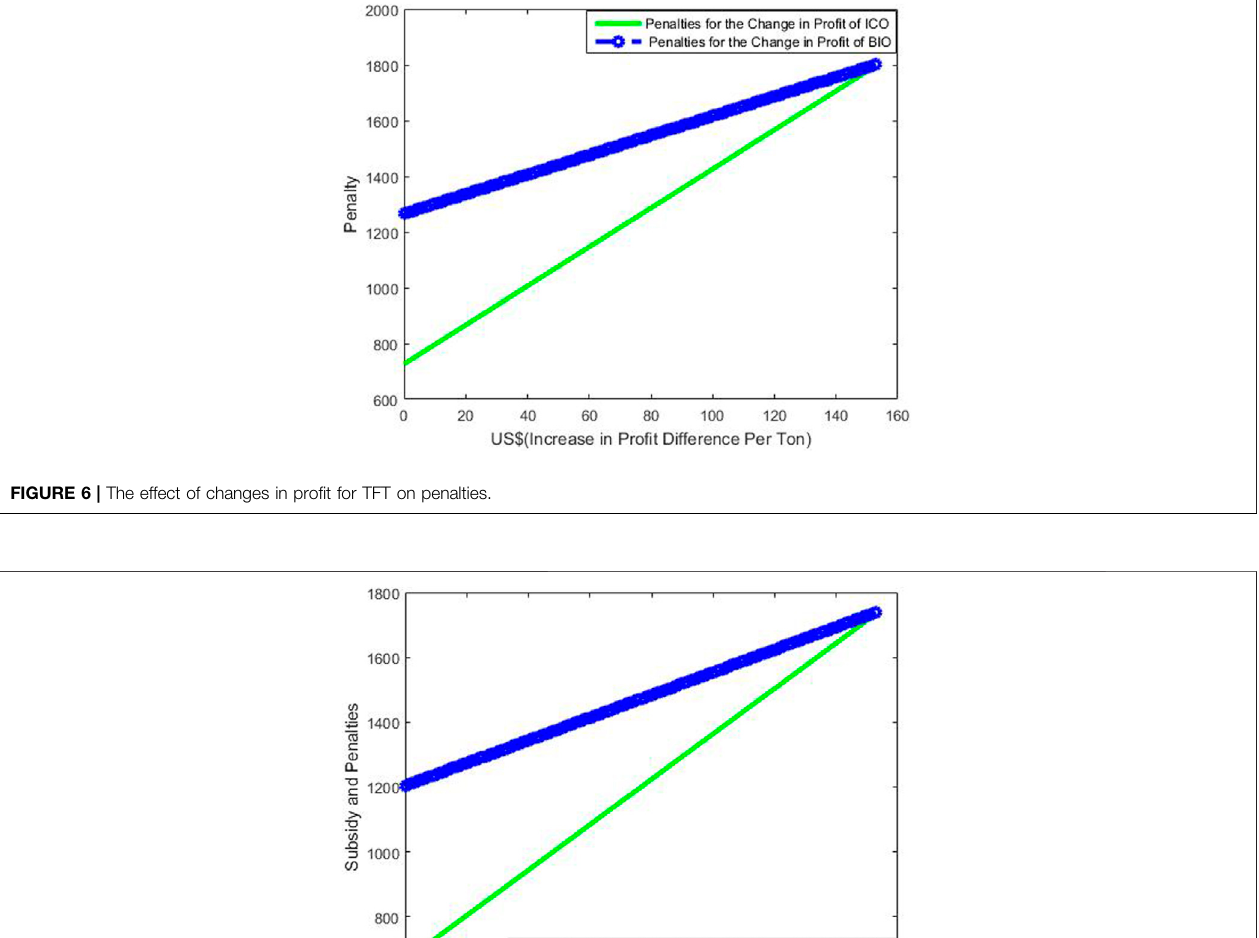
Frontiers in Energy Research |